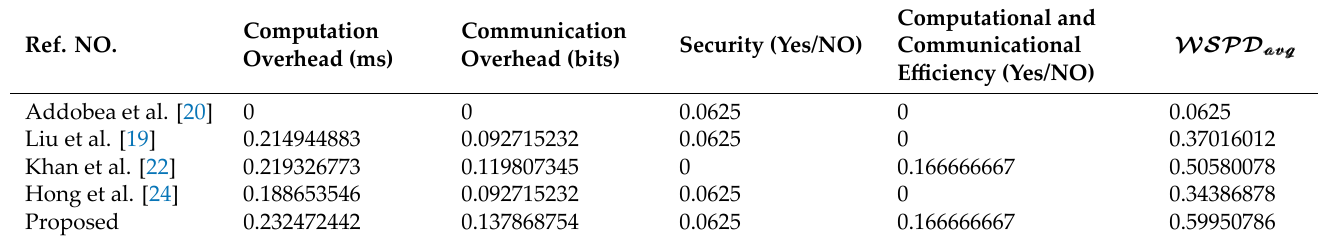
Table 12. Weighted sum of the positive distance.